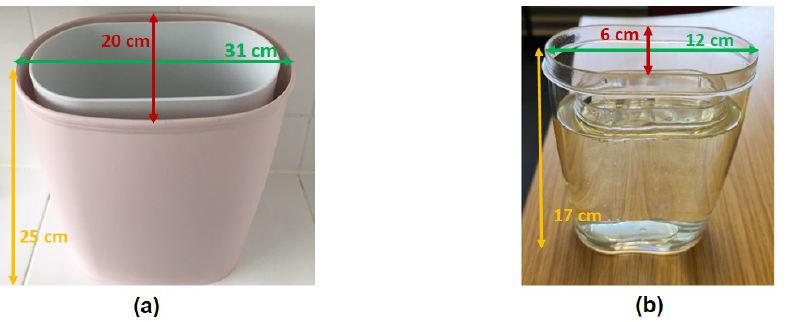
Figure 1. ( a ) Fabricated realistic torso phantom used for measurements inside anechoic chamber; ( b ) the miniaturized torso phantom (here without inclusion) used for MammoWave device’s